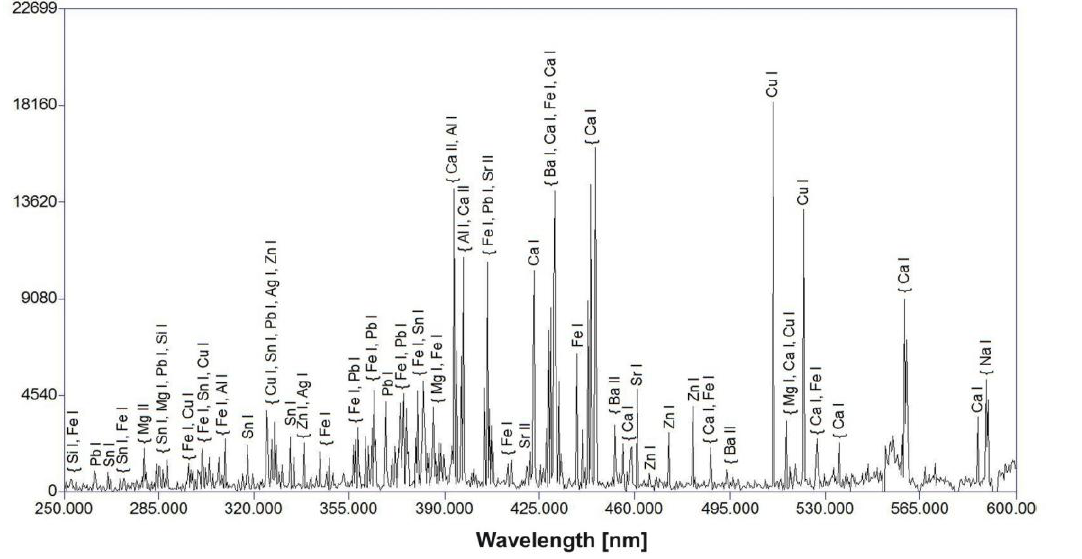
Figure 30. LIBS spectrum of the bow surface deposit.